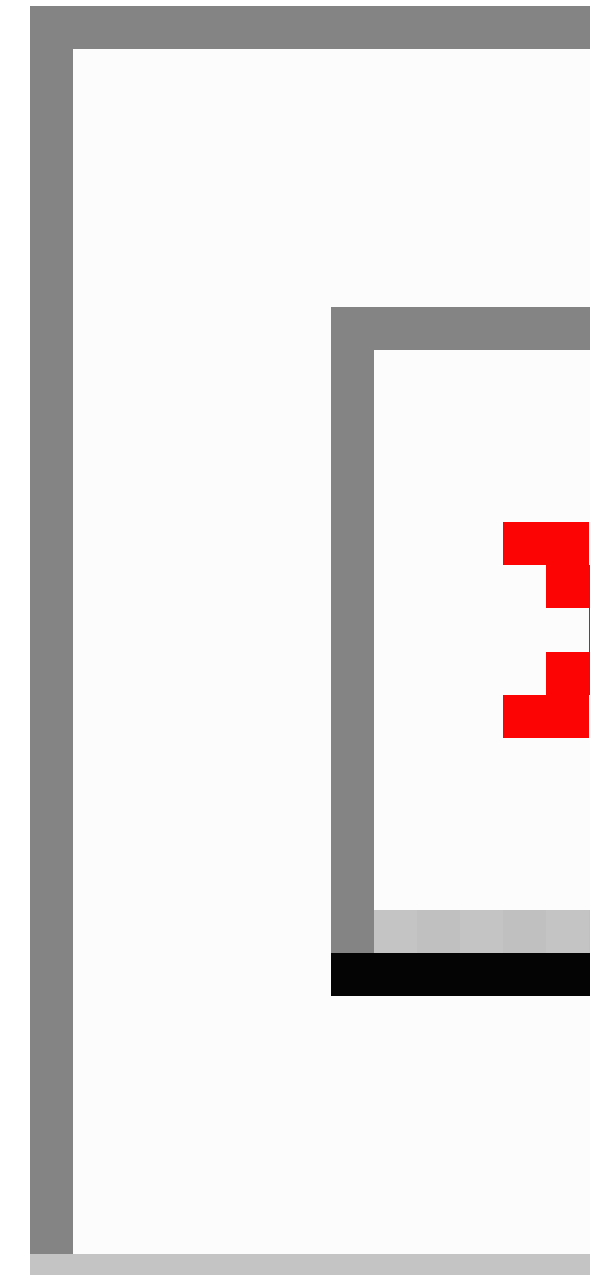
Figure 1. Development stages of the